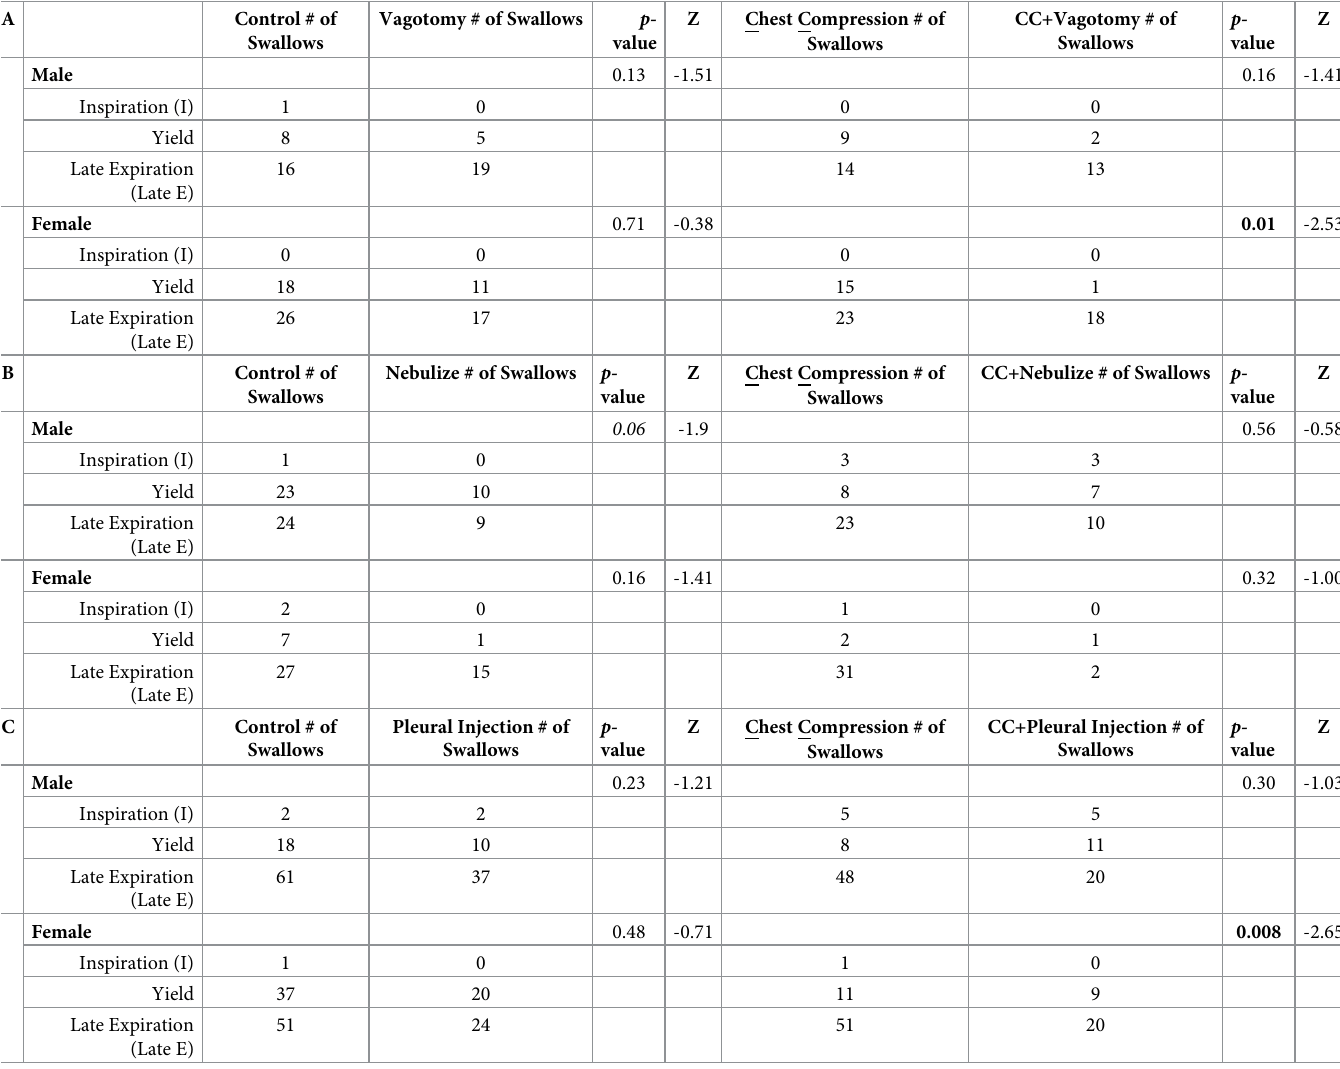
Table 4. Number of swallows during each phase of breathing during conditions of control (no feedback modulation or chest compression), feedback modulation alone (e.g. vagotomy), chest compression alone (without feedback modulation), and Chest Compression (CC) during feedback modulation conditions for both male and female groups. The left half of the table shows data comparing control conditions (no feedback modulation) to conditions adding vagotomy (A), nebulized lido- caine (B), or pleural injection of lidocaine (C), while the right half compares chest compression with the addition of each